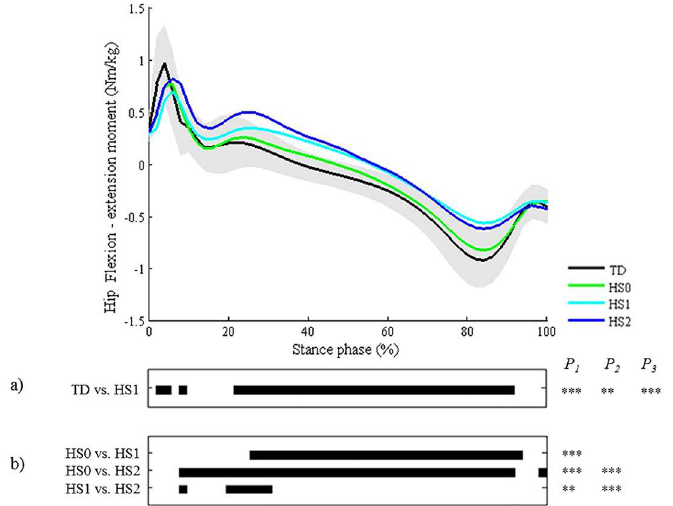
Fig 14. Hip in the sagittal plane (HS). Top graph shows the mean kinetic angle of TD gait and of each consensus-based pattern of the hip in the sagittal plane. Black bars indicate significantgait phases during which the SPM{t} statistic exceededthe critical threshold. Panel ( a ) shows results of hypothesis2 (i.e. unpairedt-tests, α = 0.01); panel ( b ) shows results of hypothesis3 (i.e. post-hoc unpairedt-tests, α = 0.003). * p < 0.01, ** p < 0.001, *** p < 0.00001.P 1 indicatesthe p-value of the first cluster duringthe stance phase, P 2 the second cluster,